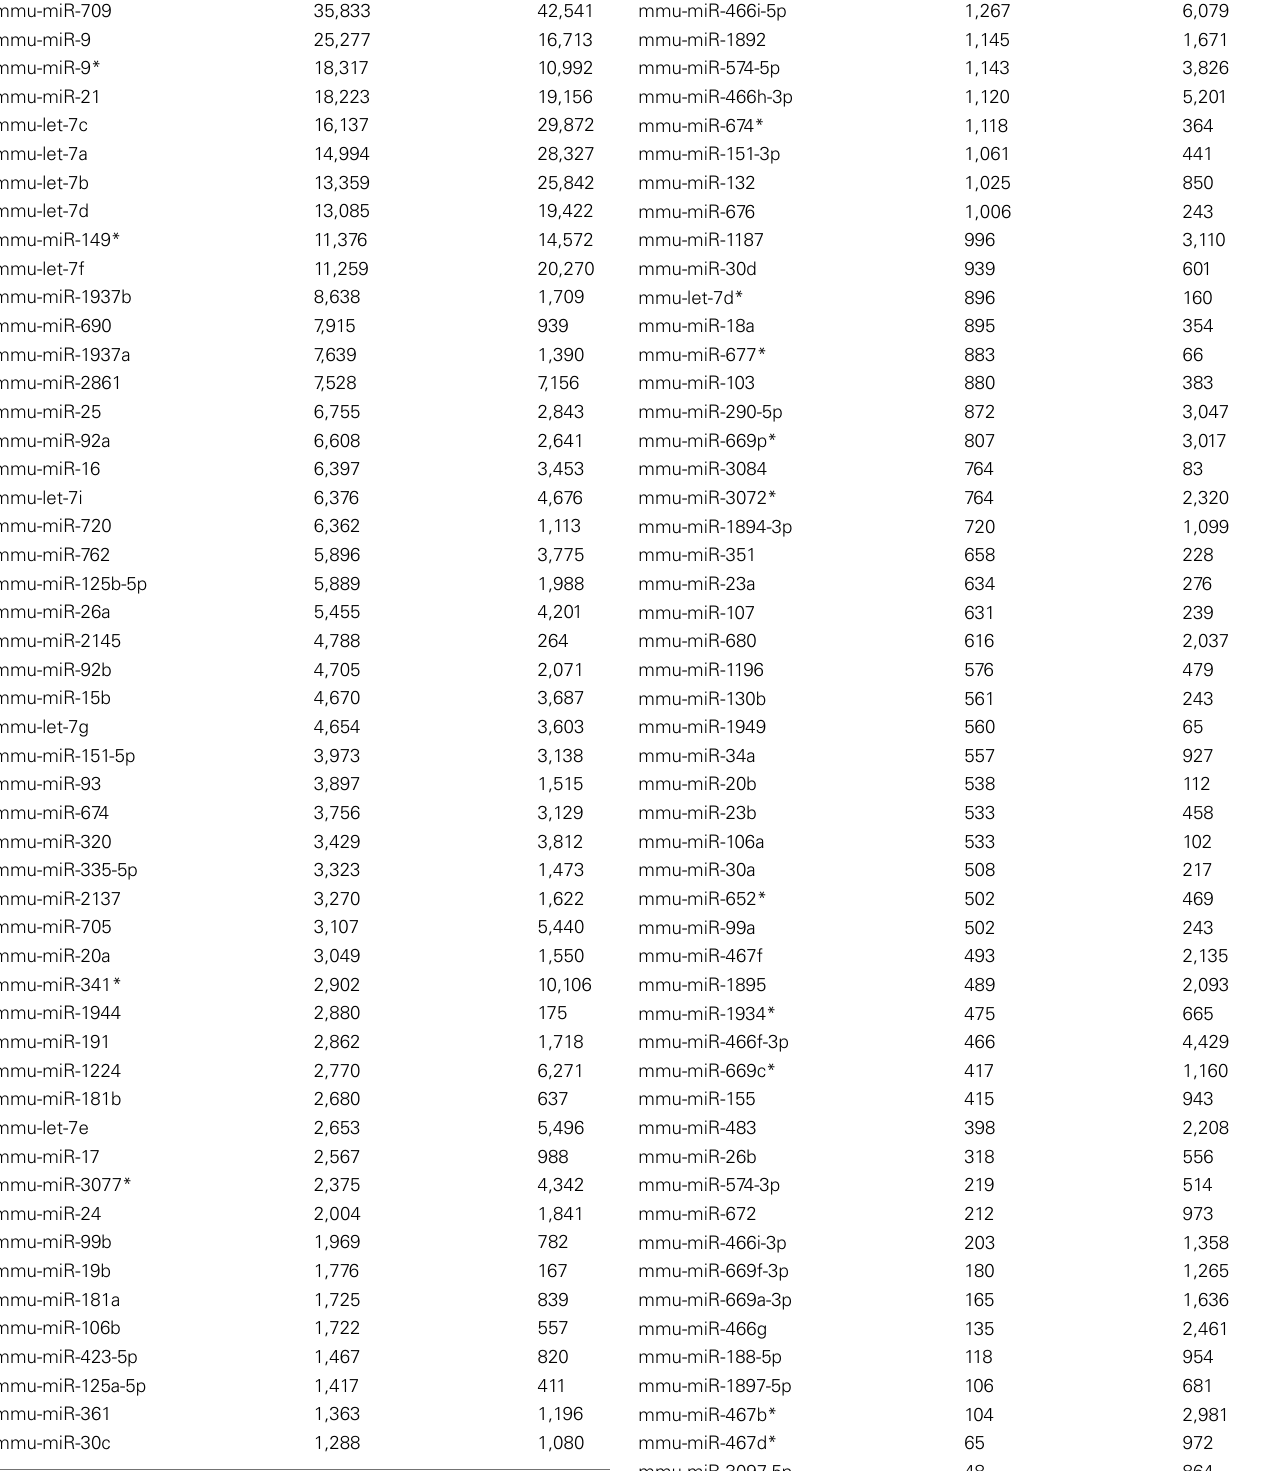
TableA1 | Highly expressed miRNAs under proliferation condition in GFP (control) and Cre-GFP (experimental)